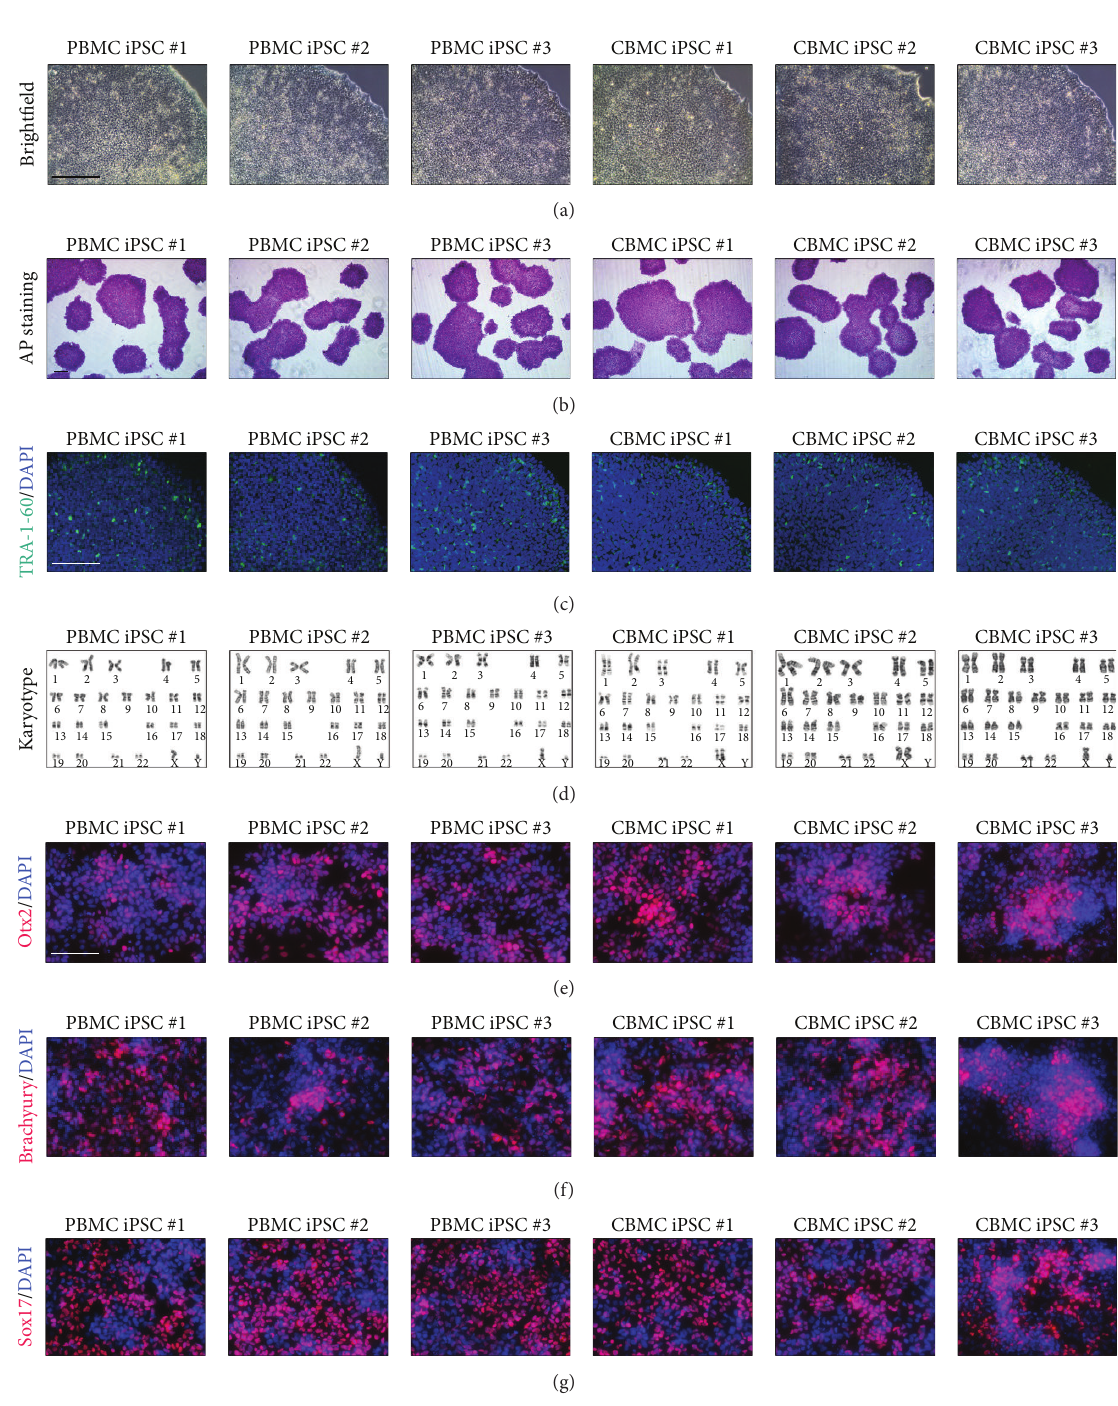
Figure 5: iPSCs generated using the established protocol. (a) Brightfield image of iPSCs generated from PBMCs and CBMCs. (b) Alkaline phosphatase staining results of generated iPSCs. (c) TRA-1-60 stained fluorescence image of iPSCs. (d) Karyotype results of generated iPSCs. All cell lines showed normal karyotype. (e) Ectoderm differentiation, (f) mesoderm differentiation, and (g) endoderm differentiation image of iPSCs. Scale bars: 200 𝜇